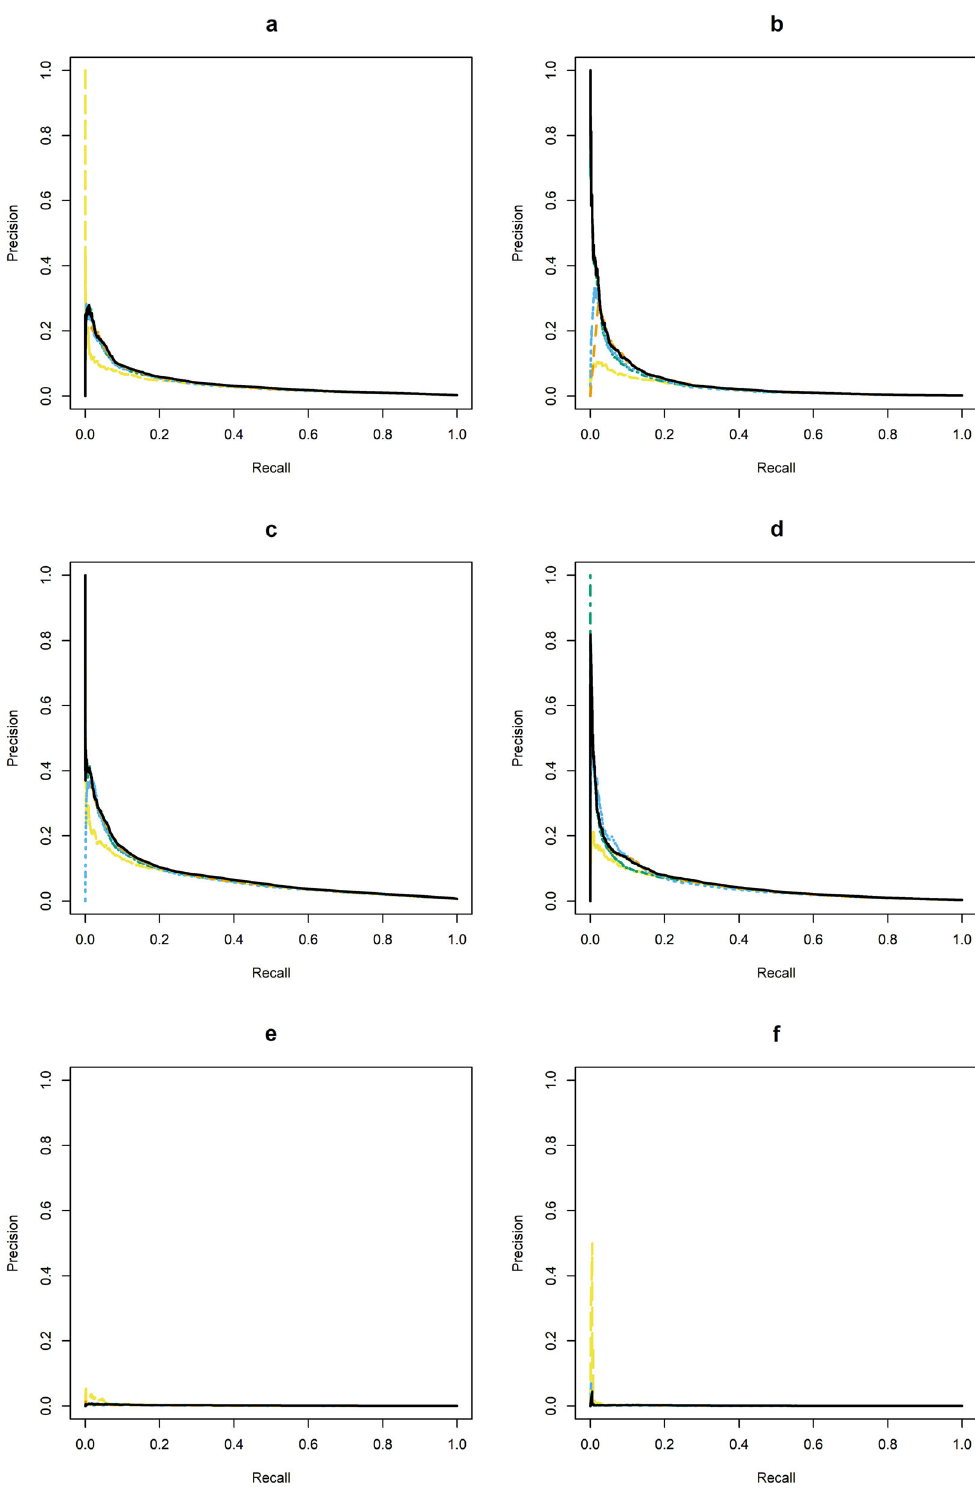
Fig. 2 Precision-recall curves for each prediction modeling approach (using optimal tuning parameters, estimated in the validation dataset) in in both settings (mental health specialty and general medical) for 30- and 90-day suicide attempt (fatal and nonfatal) models and 90-day suicide death models. Each fi gure panel represents precision-recall curves for different samples, outcomes, and follow-up periods. ( a ): 30-day suicide attempt prediction models, mental health specialty visits; ( b ): 30-day suicide attempt prediction models, general medical visits; ( c ): 90-day suicide attempt prediction models, mental health specialty visits; ( d ): 90-day suicide attempt prediction models, general medical visits; ( e ): 90-day suicide prediction models, mental health specialty visits, ( f ): 30-day suicide prediction models, general medical visits. Original parsimonious (yellow long-dashed line); Logistic regression with lasso variable selection (green long-short-dashed line); Random forest (blue short-dashed line); Arti fi cial neural network (orange medium-dashed line); Ensemble = ensemble model using logistic regresssion, random forest, and arti fi cial neural network models with detailed temporal predictors (solid black